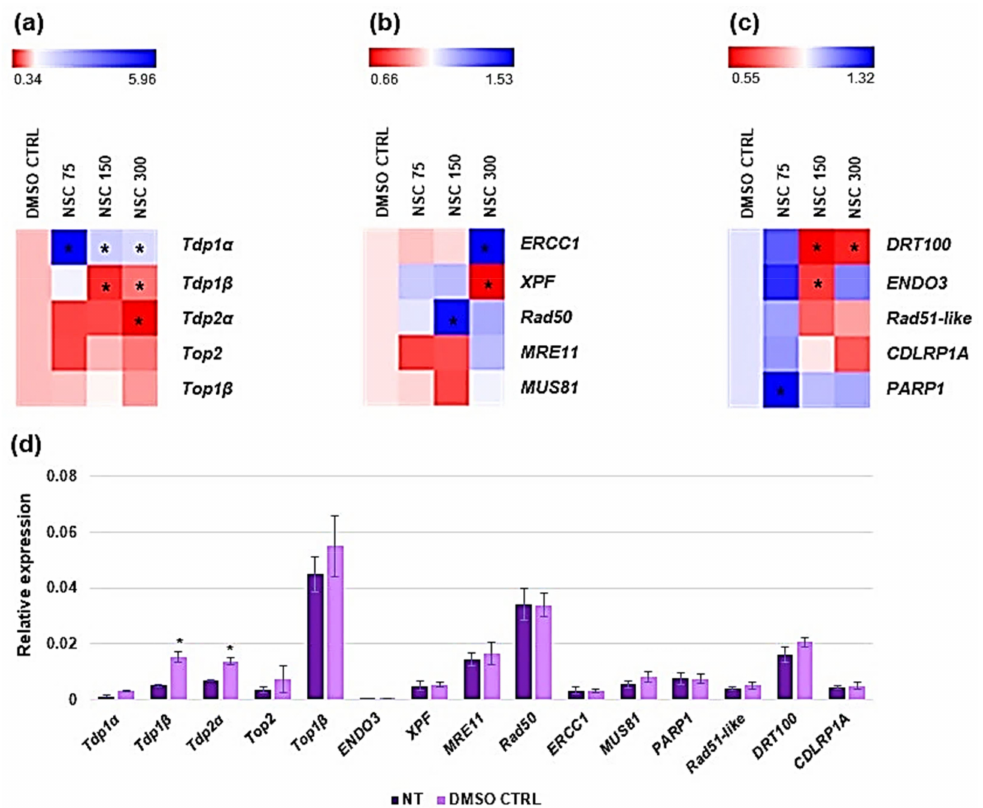
Figure 5. Expression profiles DNA damage repair (DDR) genes in response the increasing concentrations (75 µ M, 150 µ M and 300 µ M) of NSC120686 delivered to M. truncatula calli for a four-day period. ( a ) Heatmaps grouping the Tdp and Top genes. ( b ) Heatmaps grouping genes belonging to alternative-Tdp1 repair pathways. ( c ) Heatmaps grouping potential Tdp1 α interactors. ( d ) Expression profiles of DDR genes in NT and DMSO CTRL. Heatmaps were generated using MeV (Multiple Experiment Viewer) online software (http://mev.tm4.org). Data are presented as fold change to DMSO CTRL. Asterisks (*) indicates significant differences ( p < 0.05) to control as revealed by the t -Student